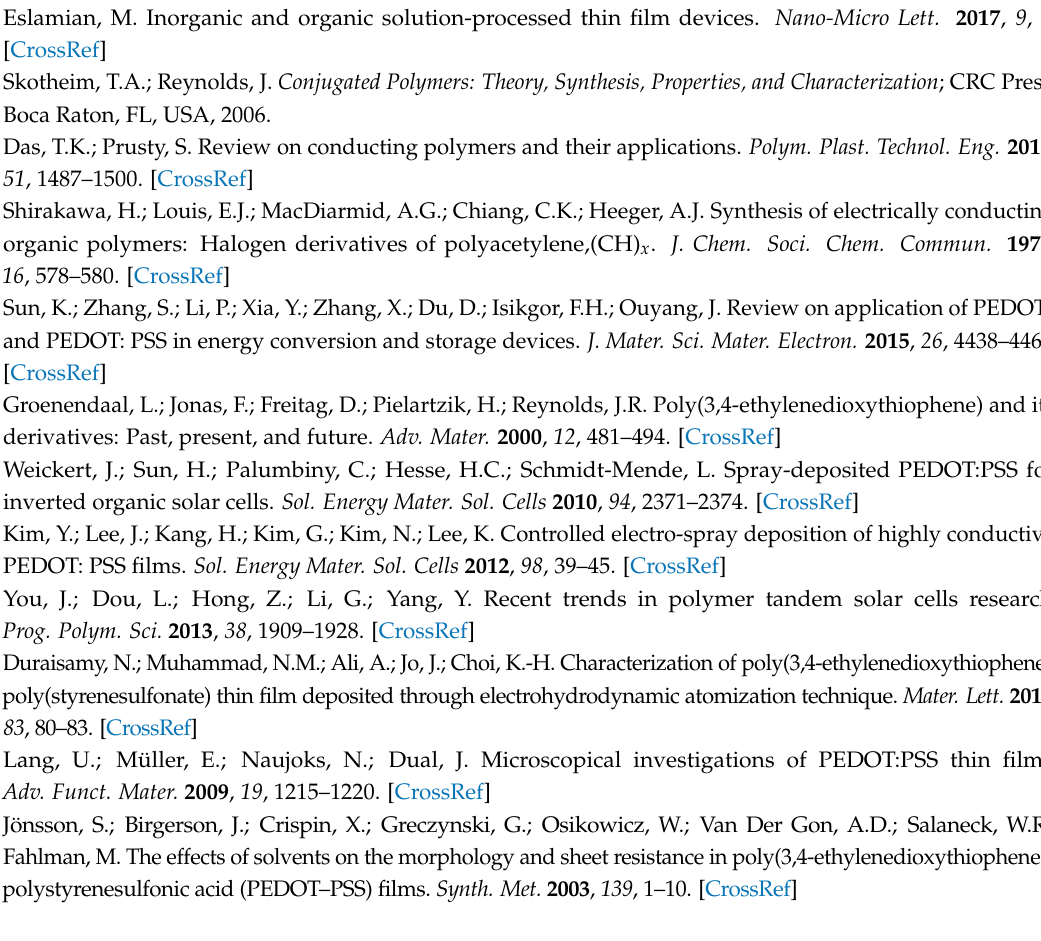
s1, Table S1: Temperatures ( T ) of the wet film and surface of the dry substrate and the vibrating steel box during vibration, taken at room temperature (~22 ◦ C), Table S2: Sheet resistance ( R s ) of PEDOT:PSS films spun on glass/ITO and PET/ITO substrates and treated at different frequencies and powers, Figure S1: Noise characterization of the base used during vibration analysis, Figure S2: AFM phase images of pristine PEDOT:PSS films, Figure S3: AFM phase images showing the effect of vibration power and frequency on PEDOT:PSS films treated by the SVPT, Figure S4: SEM images of pristine spun PEDOT:PSS thin films, Figure S5: SEM images showing the effect of vibration power and frequency on the film topography of PEDOT:PSS films treated by the SVPT, Figure S6: Broadband transmittance of the pristine and vibrated (SVPT) PEDOT:PSS films deposited on (a) glass/ITO and (b) PET/ITO